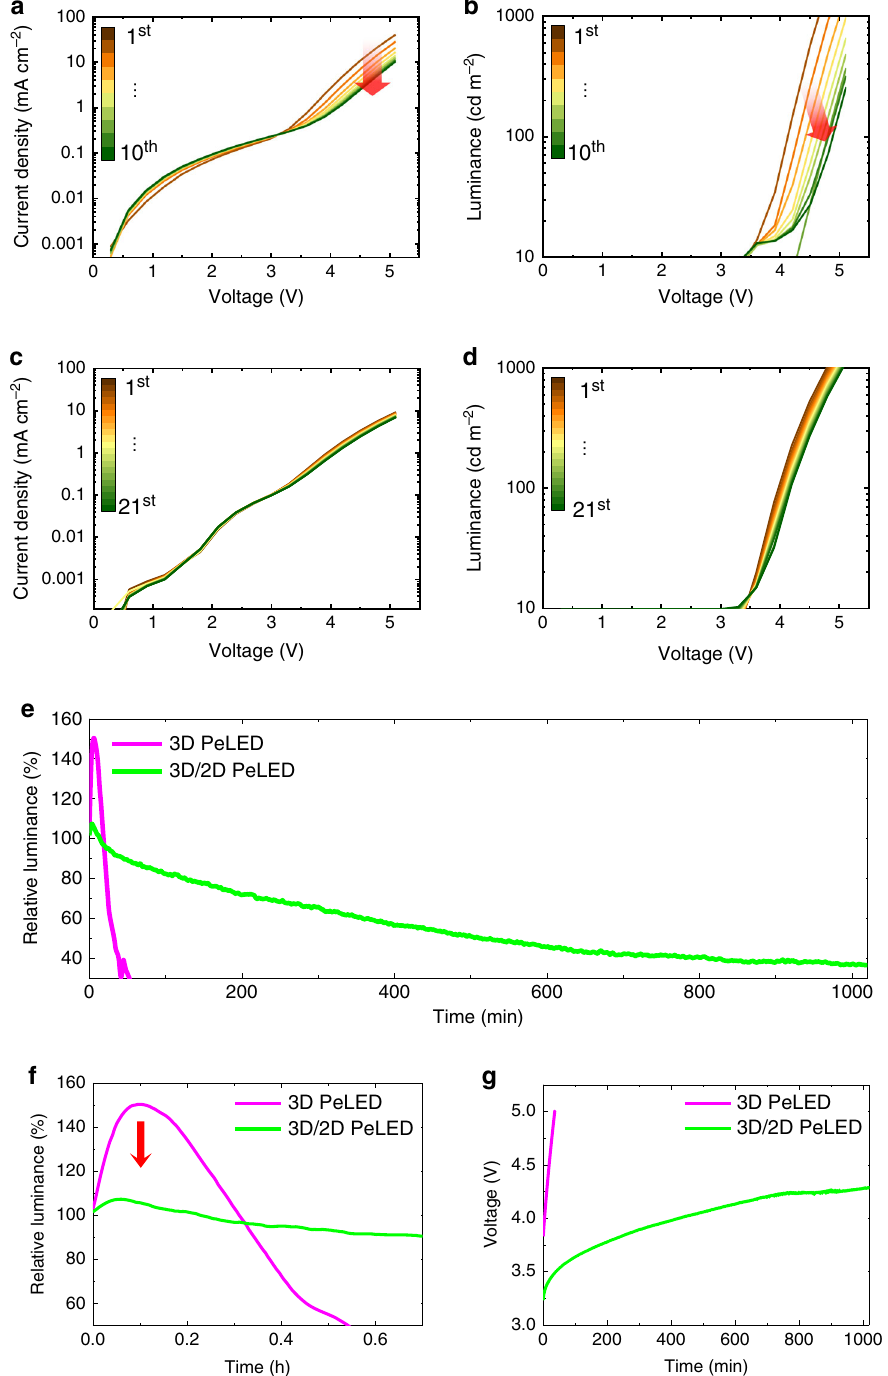
Fig. 8 Reliability and long-term stability of PeLEDs. a J – V and b L – V curves of 3D PeLEDs with a repetition of voltage sweep and c , d those of 3D/2D hybrid PeLED. e Relative luminance of 3D/2D hybrid PeLED (green) and of 3D PeLED (red) over time. f Magni fi ed version of relative luminance of PeLEDs showing an extremely reduced overshoot of luminance. g Voltage curves of 3D/2D hybrid PeLED (green) and 3D PeLED (red) over time under constant current to make PeLEDs have an emission of 100 cd m − 2